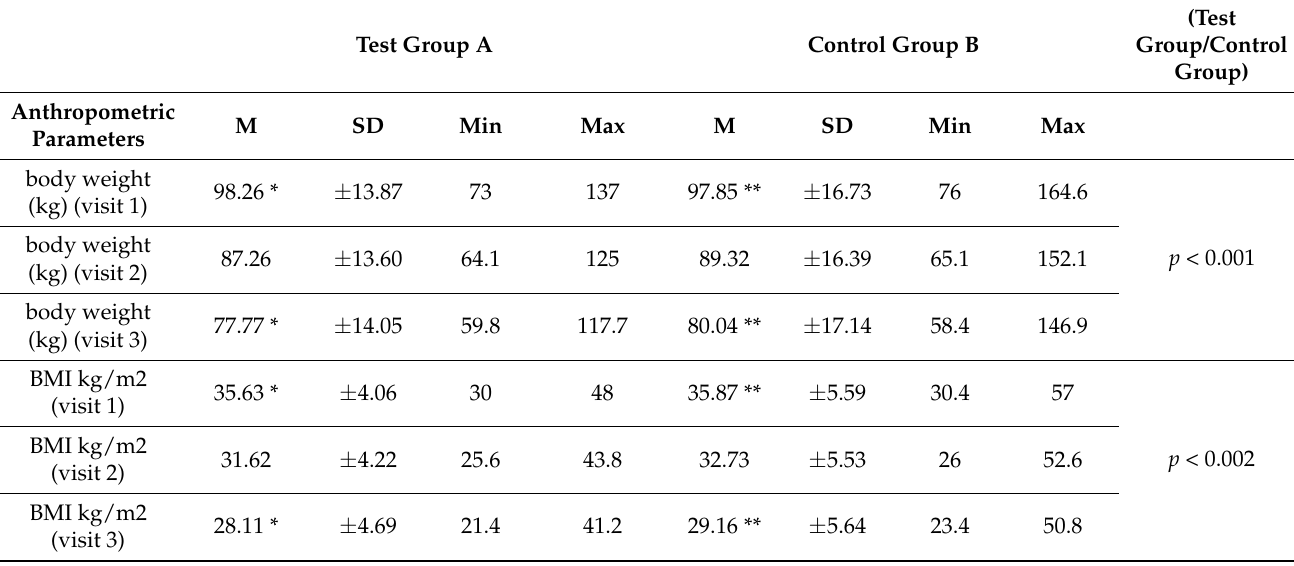
Table 1. Change in anthropometric parameters in both groups depending on the nutritional intervention